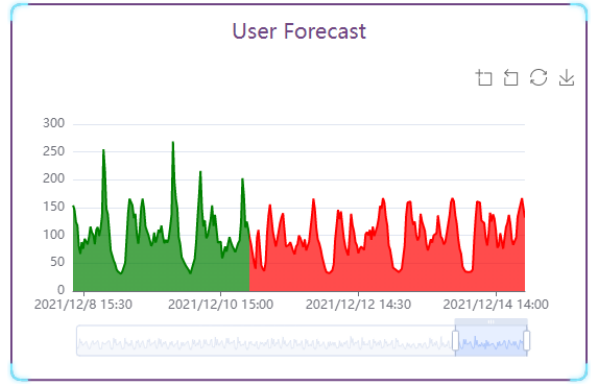
Figure 11 . Behavior